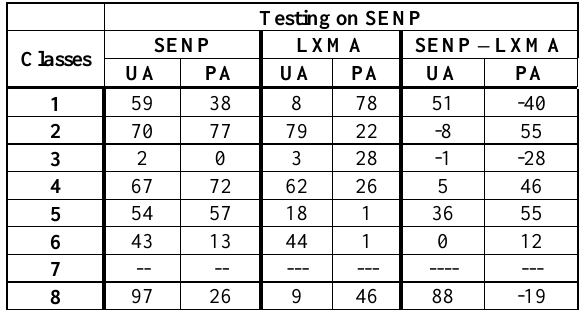
Figure 7 . For example in Figure 6, when testing in LXMA region. The model trained with PNSE data while being able to map the artificial surfaces class it struggles in differentiating agricultural areas from open spaces with little or no vegetation and herbaceous vegetation. In Figure 7 , when testing in SENP, the model trained with LXMA just reflects the poor accuracy for that region, where the model classified most of the region with the artificial surfaces or forest areas.